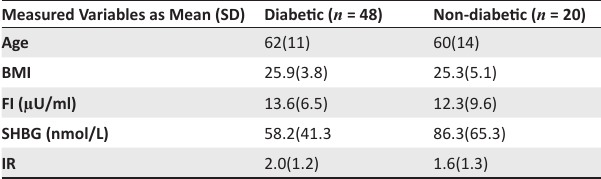
TABLE 1: Descriptive characteristics.